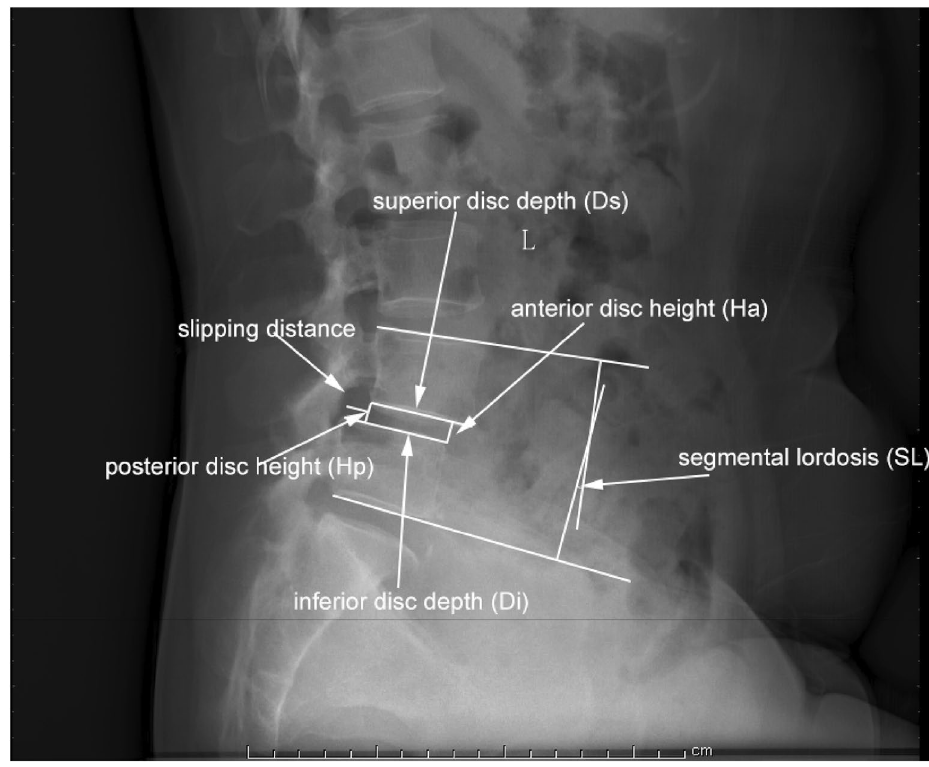
Figure 7. Parameters measured on X-ray radiographs. Anterior disc height index (DHIA) = [Ha/ (Ds + Di)] *100%. Posterior disc height index (DHIP) = [Hp/(Ds + Di)] *100%.